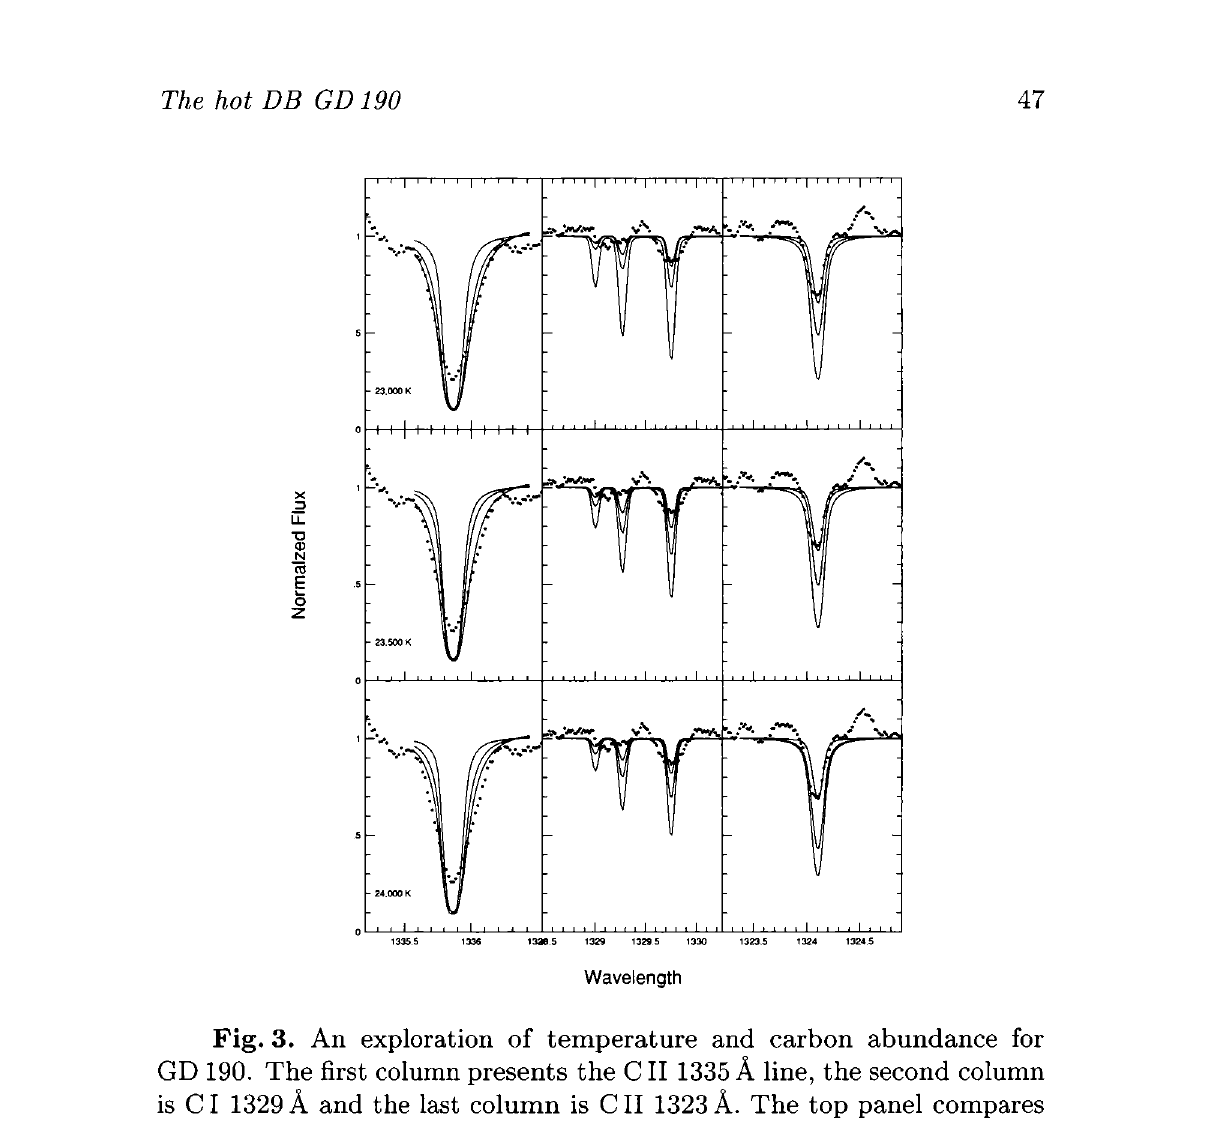
Fig. 3. An exploration of temperature and carbon abundance for GD 190. The first column presents the CII 1335 A line, the second column is CI 1329 A and the last column is CII 1323 A. The top panel compares GD 190 with three theoretical 23 000 K models with log(C/He)= -5.2, - 5.6, and -5.9 (solid lines). The middle panel increases the temperature to 23 500 K and the bottom panel uses 24 000 K models. All models are logs =